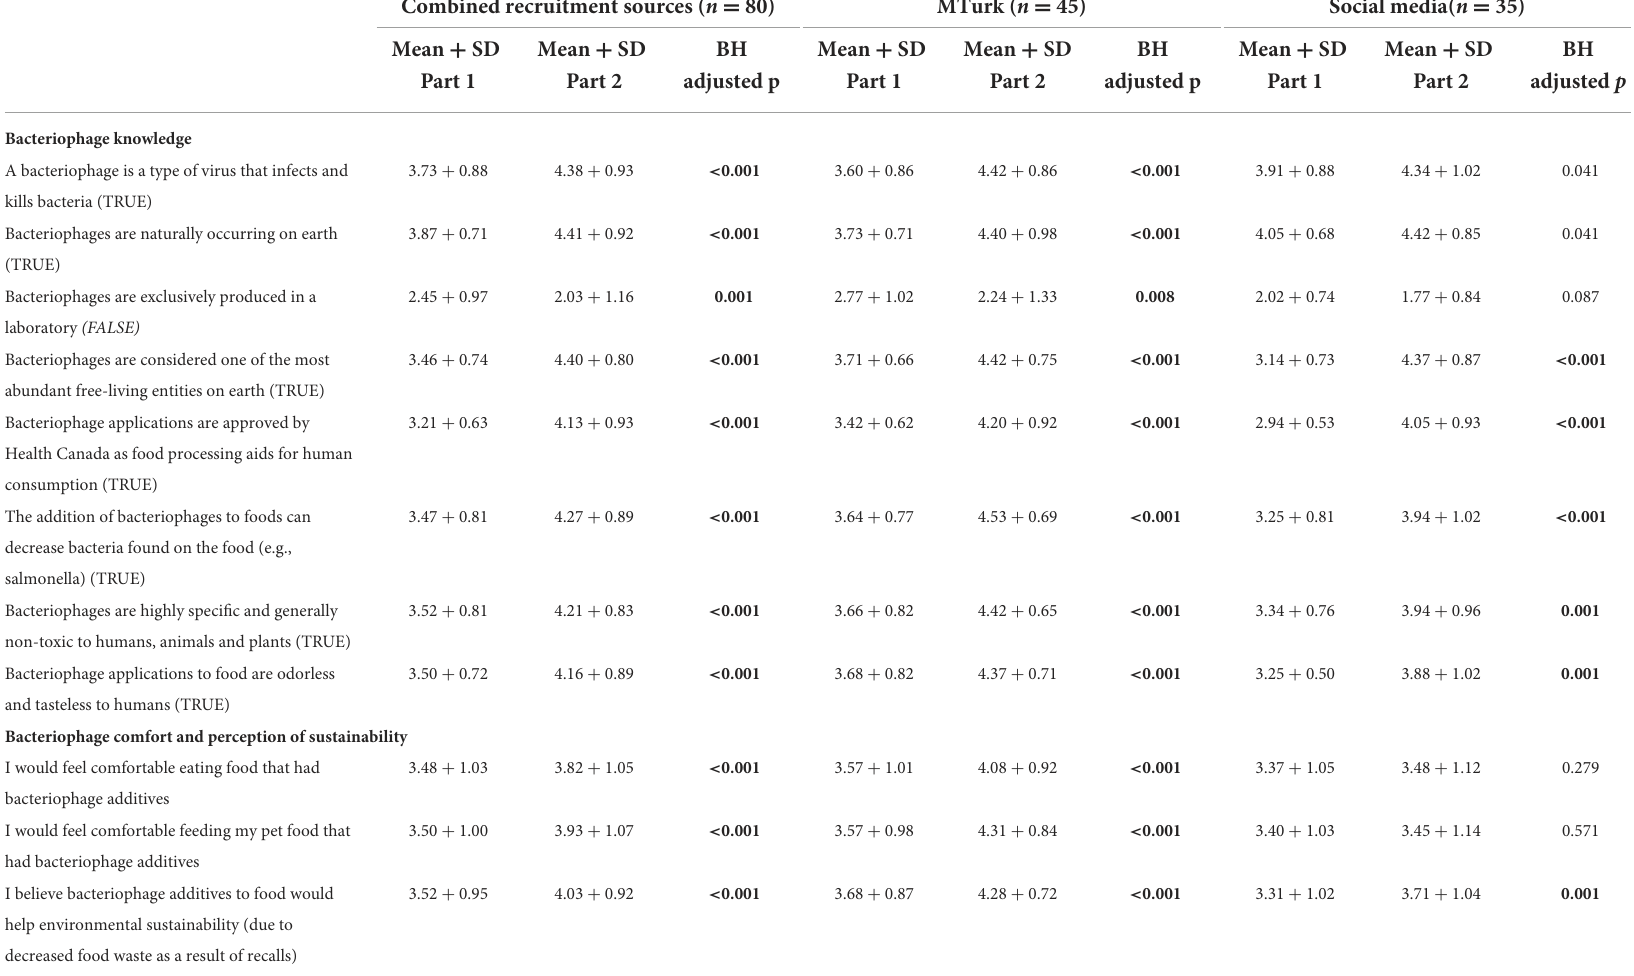
TABLE 2 Mean responses before and after completion of the educational component of the questionnaire with paired t -test statistics and Benjamini-Hochberg (BH) adjusted p values for multiple comparisons. Combined recruitment sources ( n = 80) MTurk ( n = 45) Social media( n = 35) Mean + SD Mean + SD BH Mean +